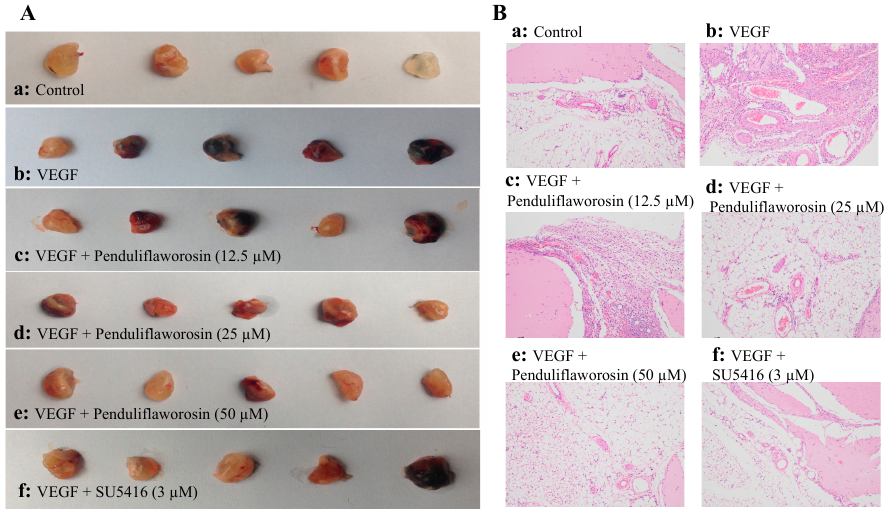
Figure 5. Penduliflaworosin inhibited VEGF-induced blood vessel formation in vivo. The ventral area of C57/BL/6 mice was injected with 300 µ L of Matrigel containing various concentrations of compounds in presence of VEGF (250 ng) and heparin (150 units). After incubation for 21 days, the Matrigel plugs were harvested. ( A ) The Matrigel plugs were photographed; ( B ) the Matrigel plugs were fixed, sectioned, and stained with hematoxylin and eosin (magnification, ×